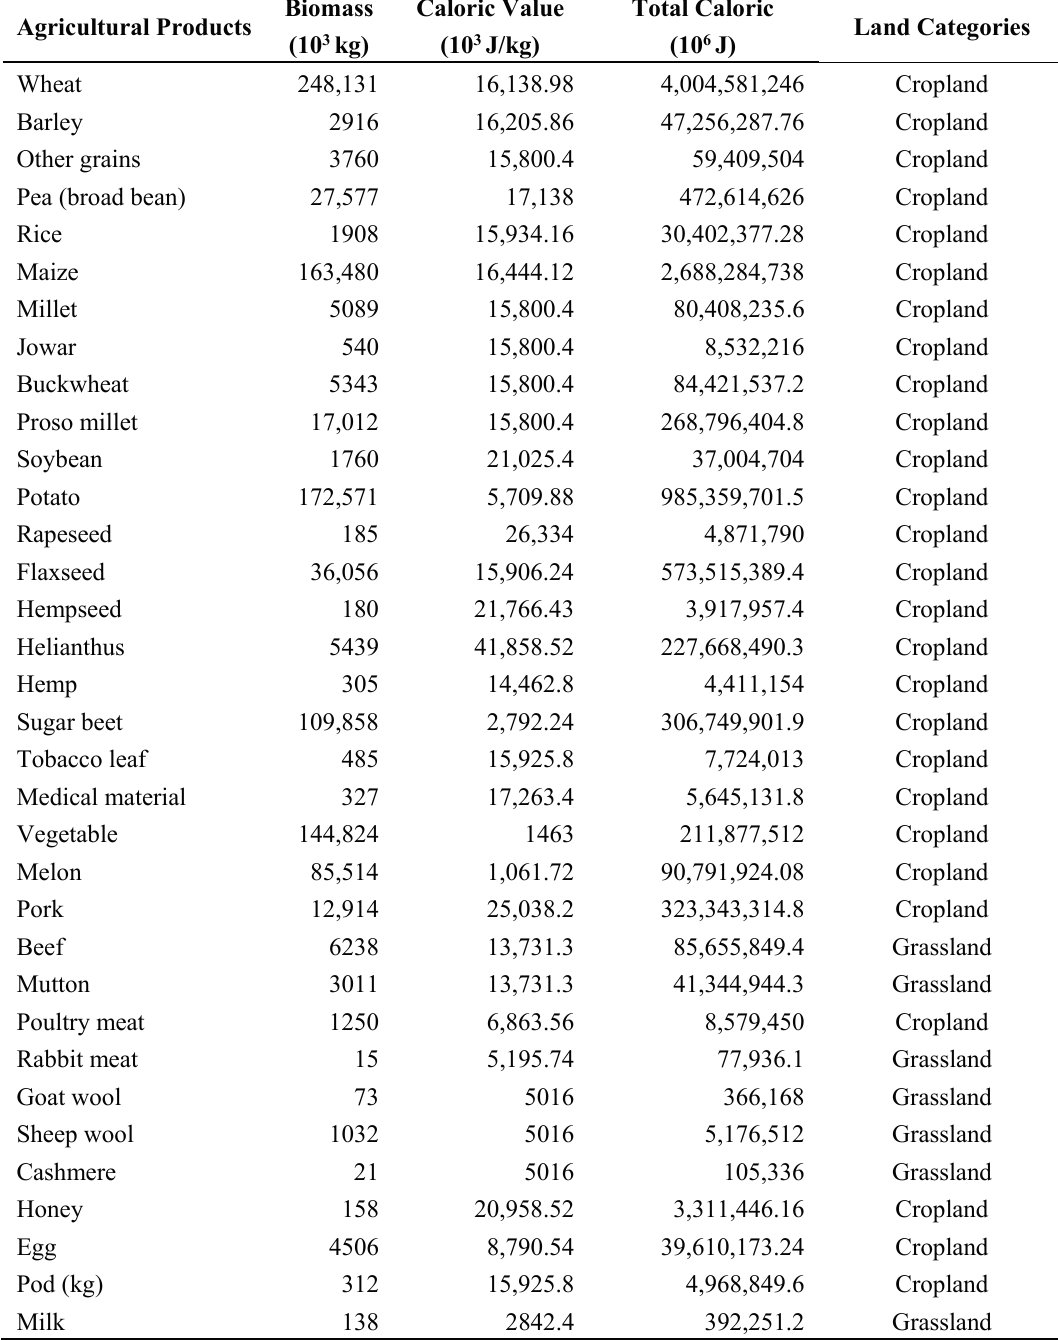
Table A3. Main biological production of Guyuan used to calculate the equilibrium factor in